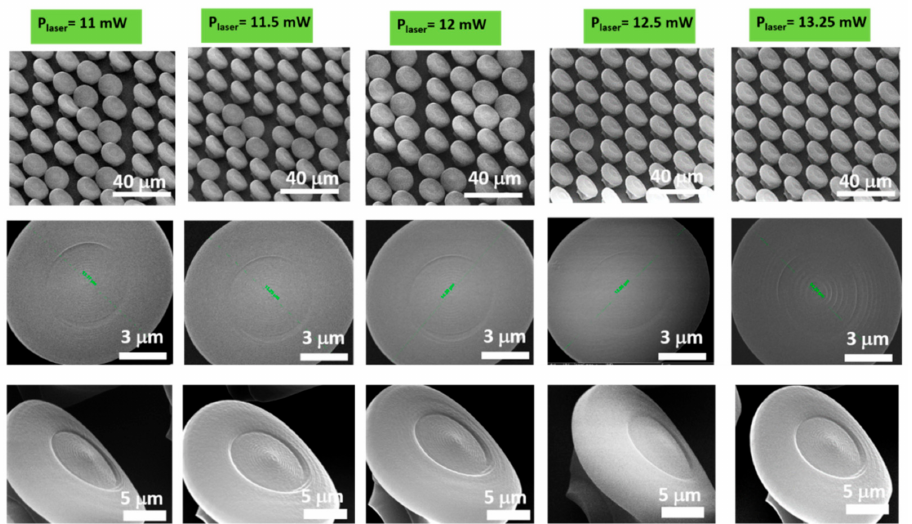
Figure 2. Scanning electron micrographs (SEM) of nanostructured mushroom-like pillars (NMPs), fabricated by LDW via TPP of IP-Dip photopolymer, imprinted using the same design and different laser powers, as indicated above each figure: ( Upper panel ) Tilted top views of NMPs arrays (tilted at 30 degrees); ( Middle panel ) Close top views of single NMP; ( Lower panel ) Tilted top views of single NMP (tilted at 30 degrees). For all samples, the scan speed was kept constant at 100 µ